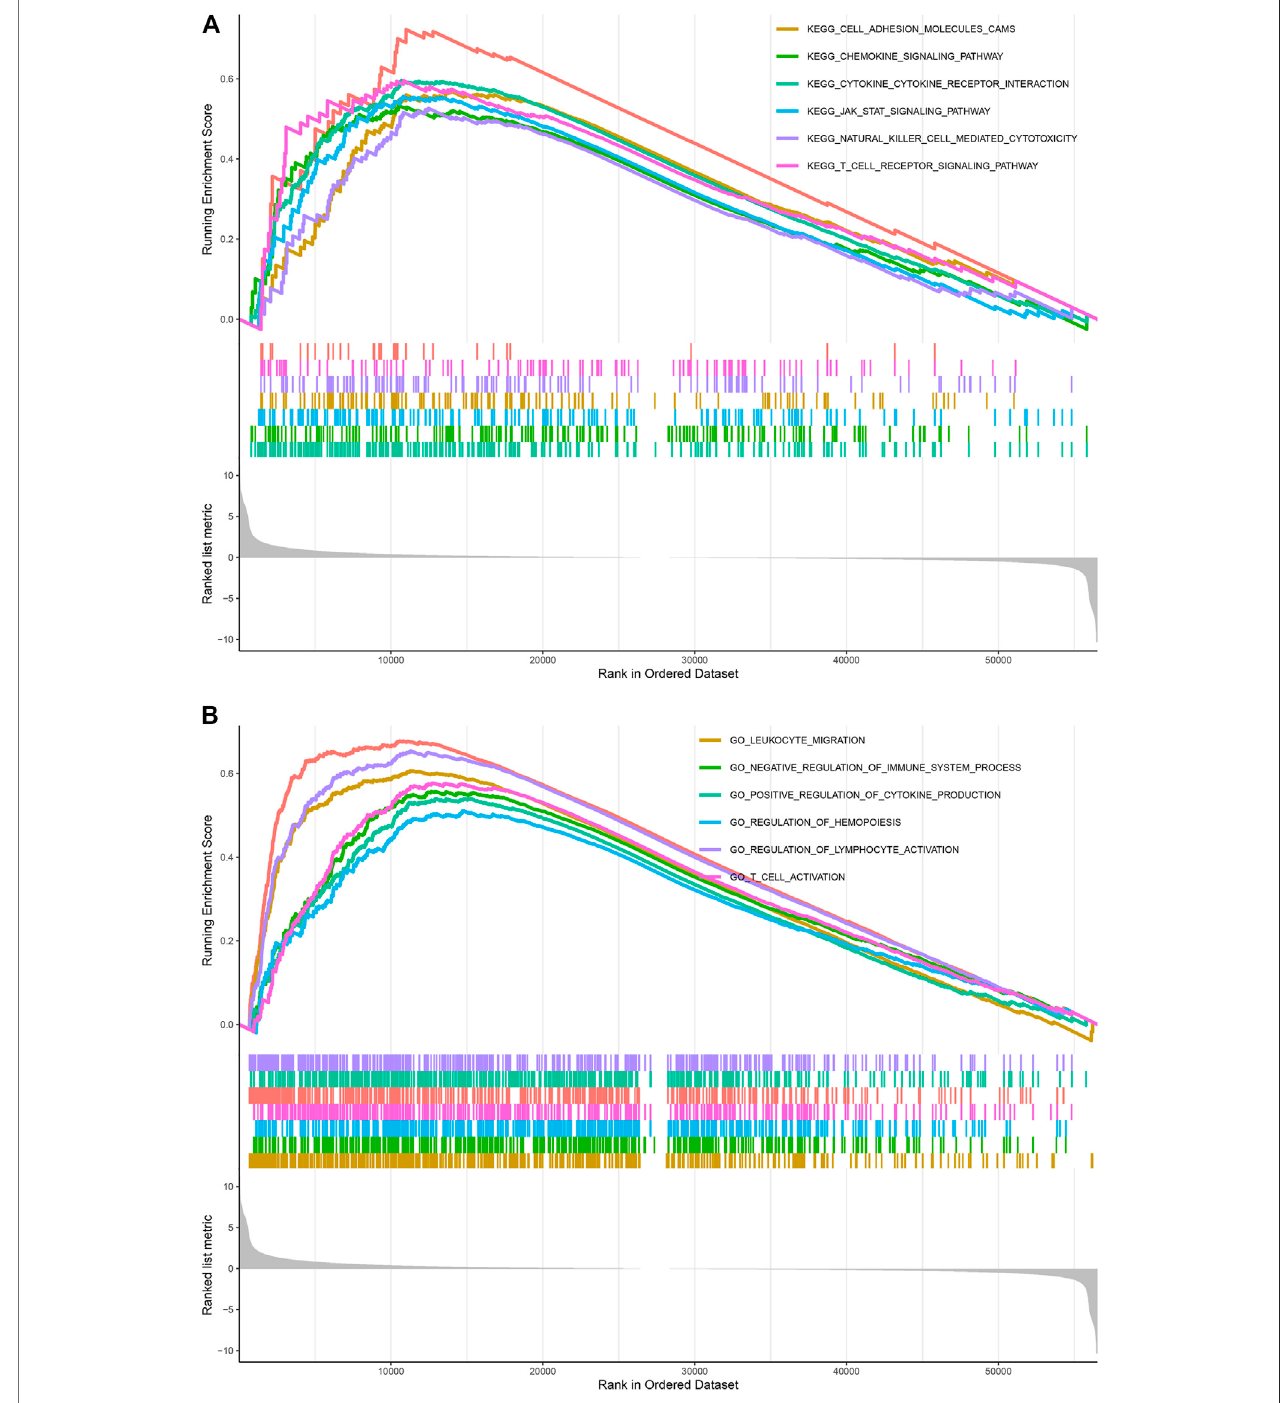
FIGURE 6 | KEGG and GO pathways enriched analyses results. (A) Enrichment of pathways in KEGG with high TUBA1C expression. (B) Enrichment of pathways in GO with high TUBA1C expression.